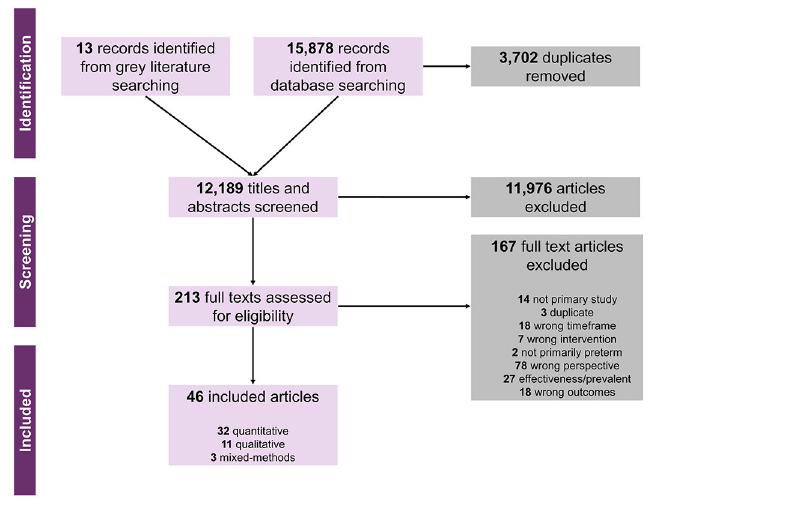
Fig 2. PRISMA flowchart depicting search and selection